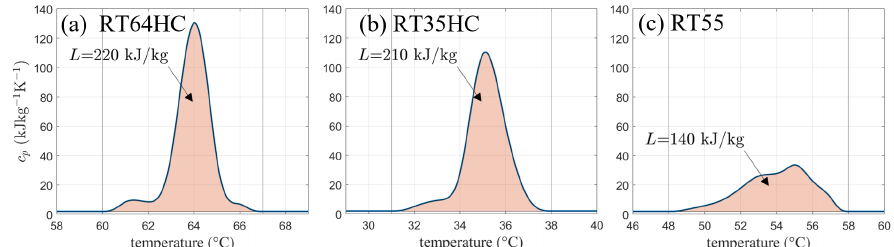
Figure 1. Heat capacity curves including the phase change enthalpy (shaded area) for different phase change materials. ( a , b ) show high performance phase change materials (PCM) with 25–30% higher latent heat storage capacity compared to class PCM materials ( c